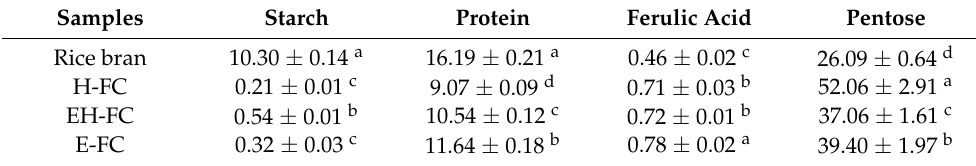
Table 1. Composition of rice bran and fiber concentrates (%, dry basis). Samples Starch Protein Ferulic Acid